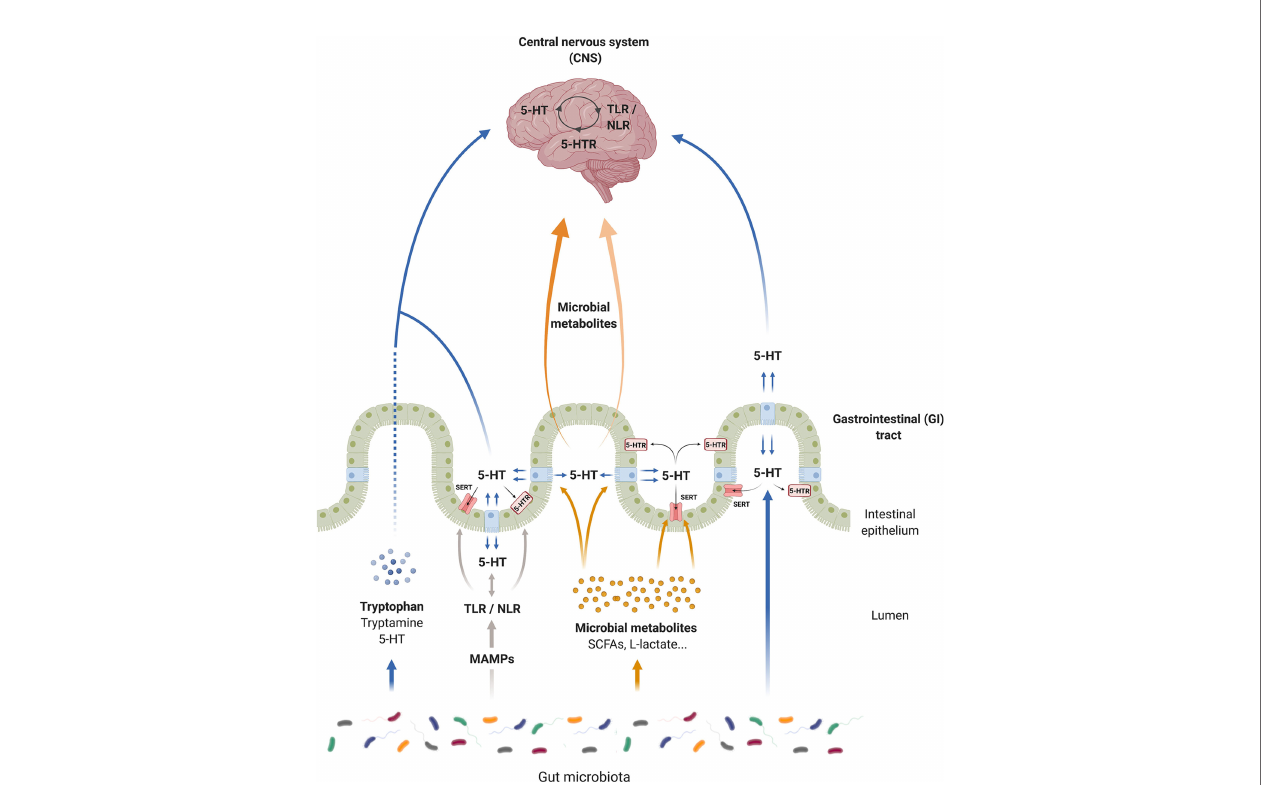
FIGURE 2 | Serotonin (5-HT) communication pathways of the microbiota – gut – brain axis. Serotonin can modulate gastrointestinal (GI) and central nervous system (CNS) functions and is a key network for the gut – brain axis. Microorganisms produce tryptophan, and degrade tryptophan, affecting the central and intestinal 5-HT production. Intestinal microbiota modulate the synthesis of 5-HT and produce 5-HT independently of the host. Microbial associated molecular patterns from microorganisms (MAMPs) through toll-like receptors (TLRs) and nucleotide oligomerization domain (NOD)-like receptors (NLRs) affect directly the serotonergic system. TLR/NLR signaling seems to modulate the activity and the expression of serotonin transporter (SERT) and serotonin receptors (5-HTRs), as well as the 5-HT synthesis in the GI tract. However, this interconnection between TLRs/NLRs and serotonergic system exists in the CNS. In a feedback regulation, 5-HT affects pattern recognition receptor (PRR) expression. In addition, microbial metabolites, such as short chain fatty acids (SCFAs), can promote 5-HT synthesis by enterochromaf fi n (EC) cells and regulate SERT activity and expression. In the same way, these metabolites can migrate into the bloodstream to reach the brain, and some of them such as L-acetate can modulate the nervous serotonergic system, controlling the expression of 5-HT